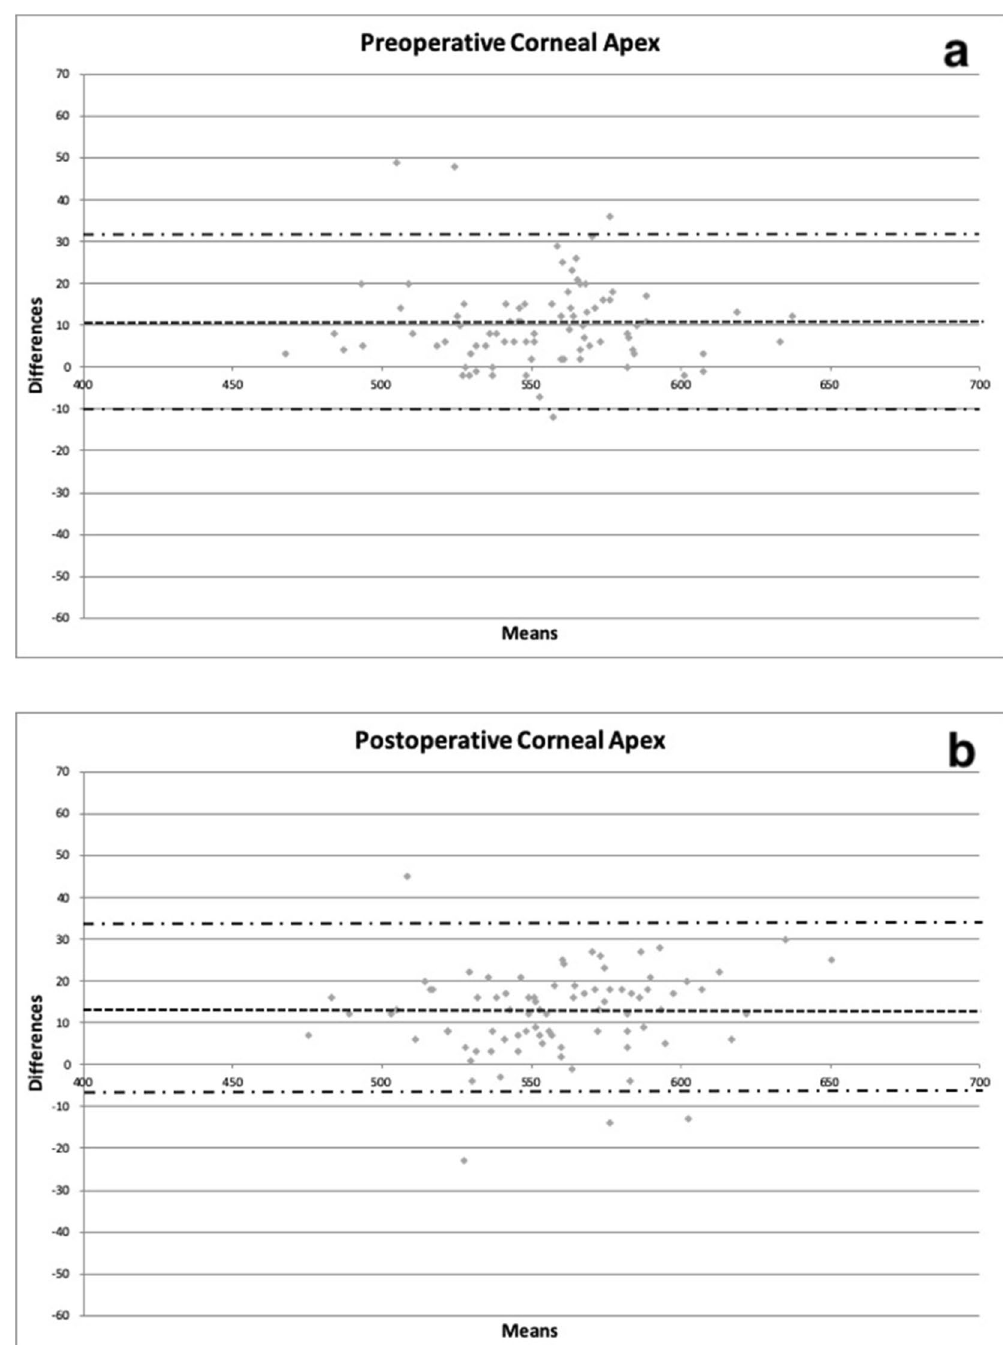
Figure 2. Bland–Altman plots between preoperative ( a ) and postoperative ( b ) corneal thickness in microns obtained with CEM-530 and Pentacam HR at the corneal apex. Dashed line: mean difference. Dash-dotted lines: mean ± 1.96 standard deviation of the